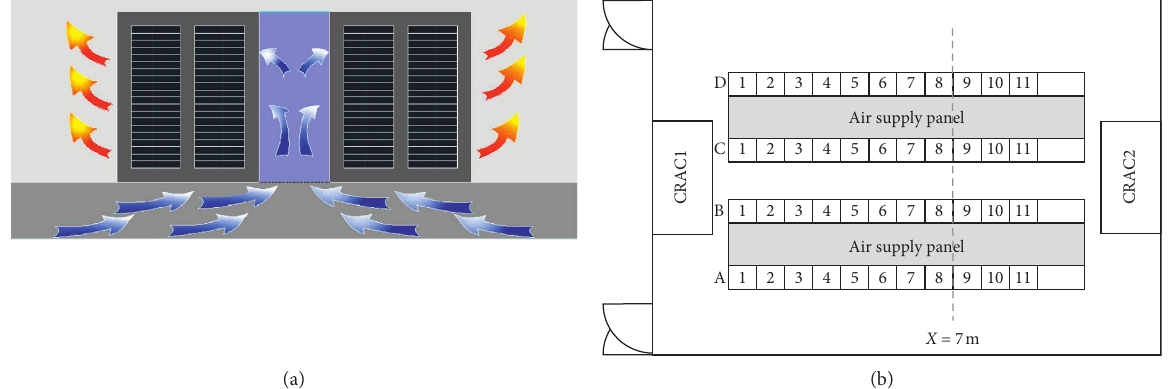
Figure 1: Physical model of the DC. (a) Air supply mode. (b) Diagram of the physical